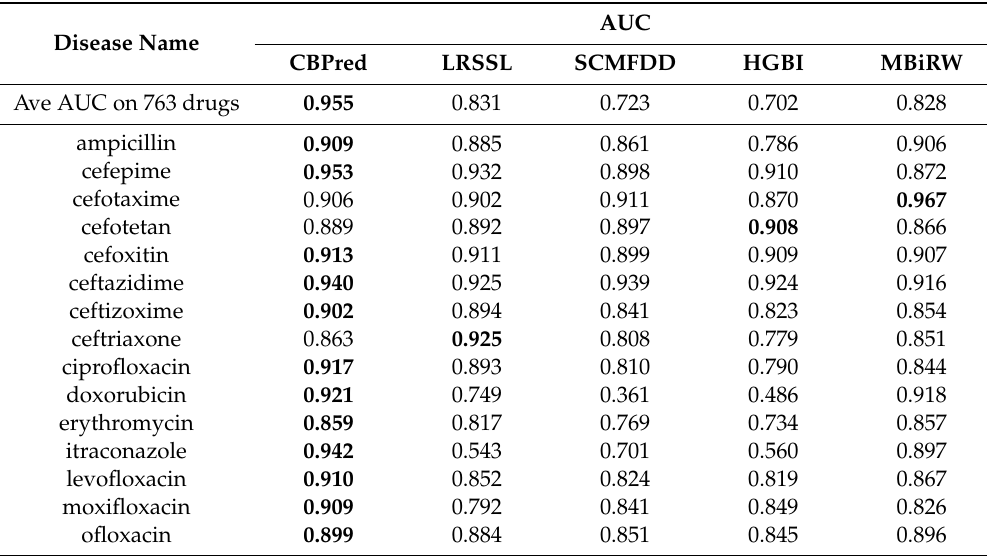
The bold values indicate the higher AUCs.